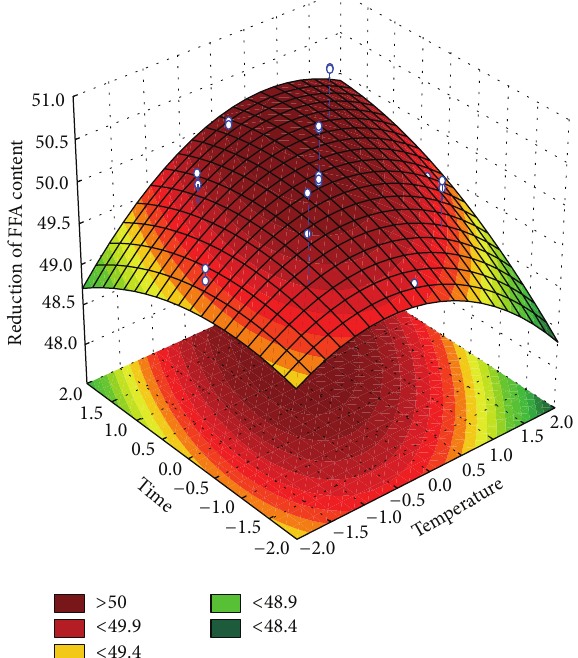
Figure 2: Response surface for neutral SODD yield in the second experimental design, effect of Na 2 CO 3 concentration, and tempera- ture (coded values at